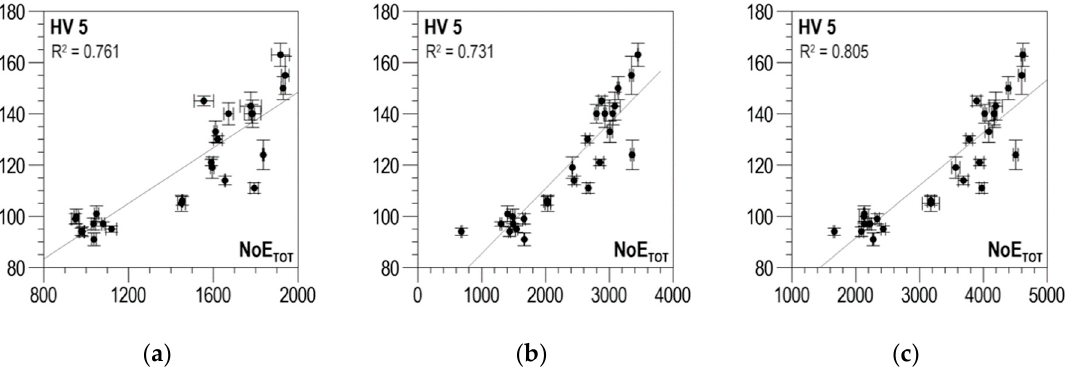
Figure 12. Linear correlations between NoE TOT and HV5 hardness—DC01 steel ( a ) parallel direction, U g = 1.7 V; ( b ) normal direction, U g = 1.1 V; ( c ) absolute value, U g = 1.1 V.